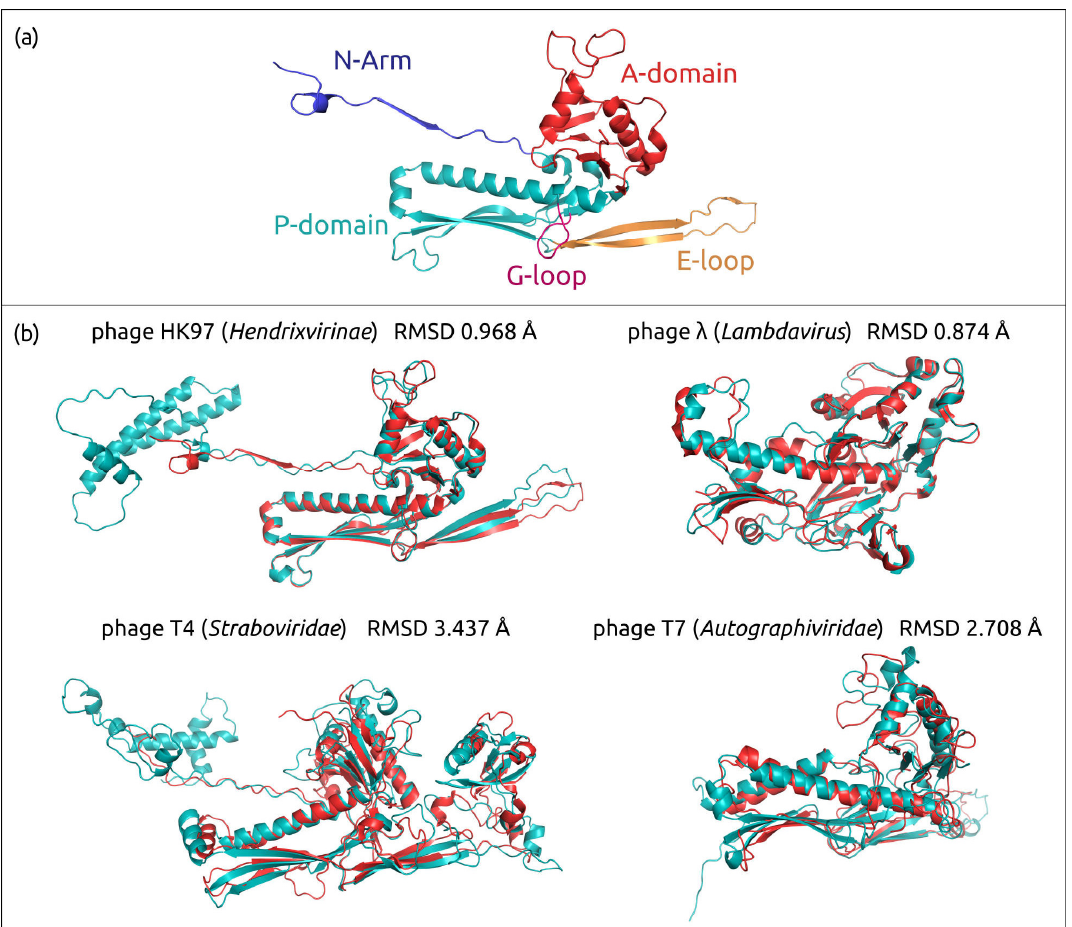
Figure 3. ( a ) The HK97 fold and its common features coloured as indicated in the figure (according to Duda et al. [67]). The diagram is of the mature HK97 capsid (PDB code 1OHG_A). ( b ) Superimposition of AF models (depicted in teal) and RCSB PDB structures (depicted red) belonging to the same viruses: 1OHG (phage HK97, the mature capsid), 7SJ5 (λ, major capsid protein mutant in the pre-assembly conformation), 5VF3 (T4, mutant MCP in the isometric capsid), 3J7V (T7) and corresponding RMSD values.